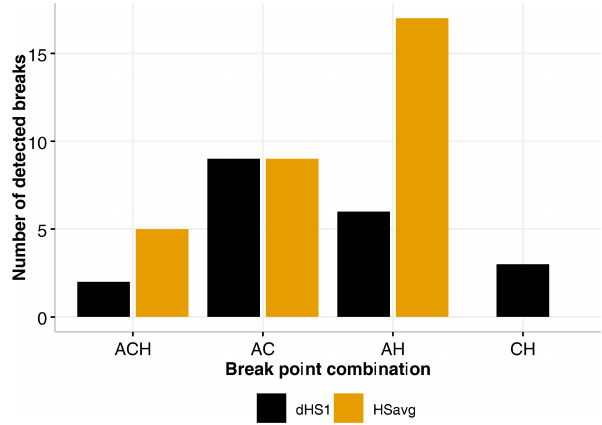
Figure 6. Method combinations for valid break points: ACMANT– Climatol–HOMER (ACH), ACMANT–Climatol (AC), ACMANT– HOMER (AH), and Climatol–HOMER